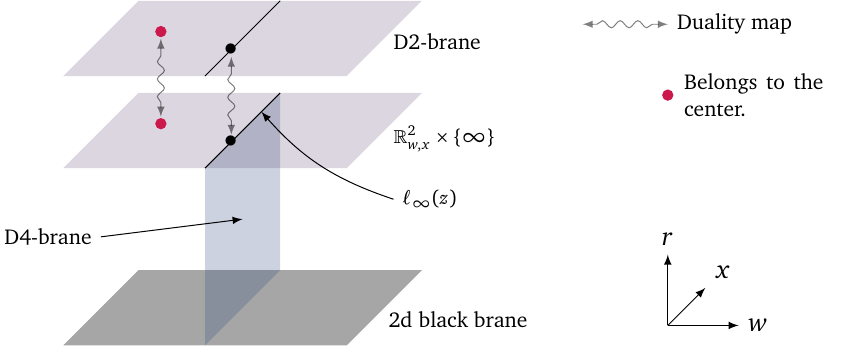
Figure 1: D2-brane, and the non-compact part of the backreacted